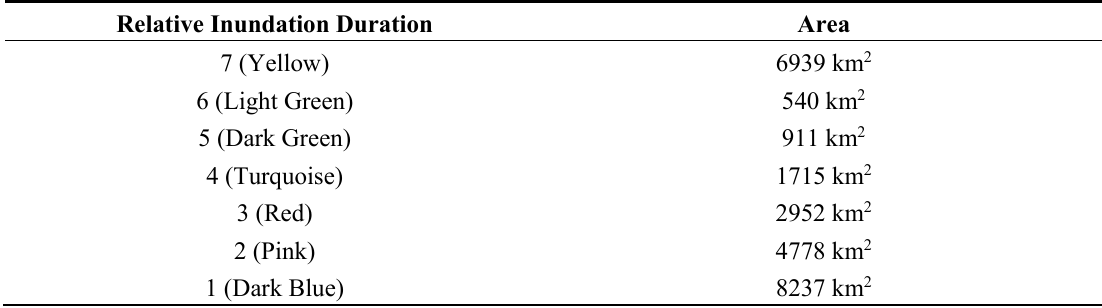
Table 8. Area of each category of relative inundation duration ( i.e. , number of dates inundated). Colors correspond with those shown in Figure